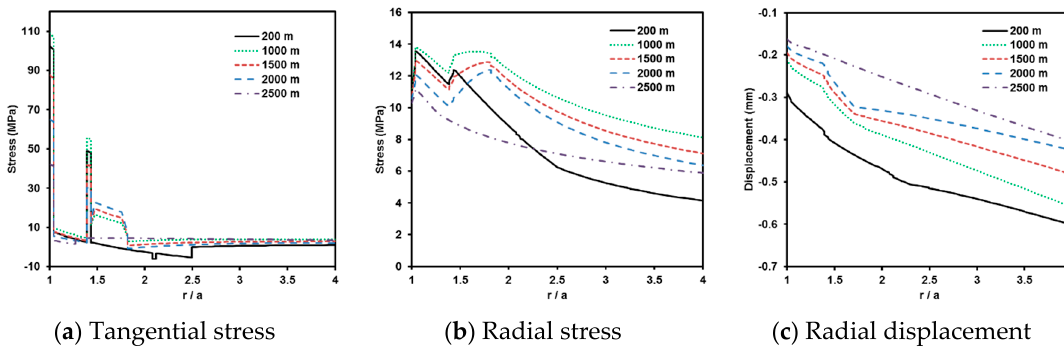
Figure 5. Stress and displacement of geothermal well.